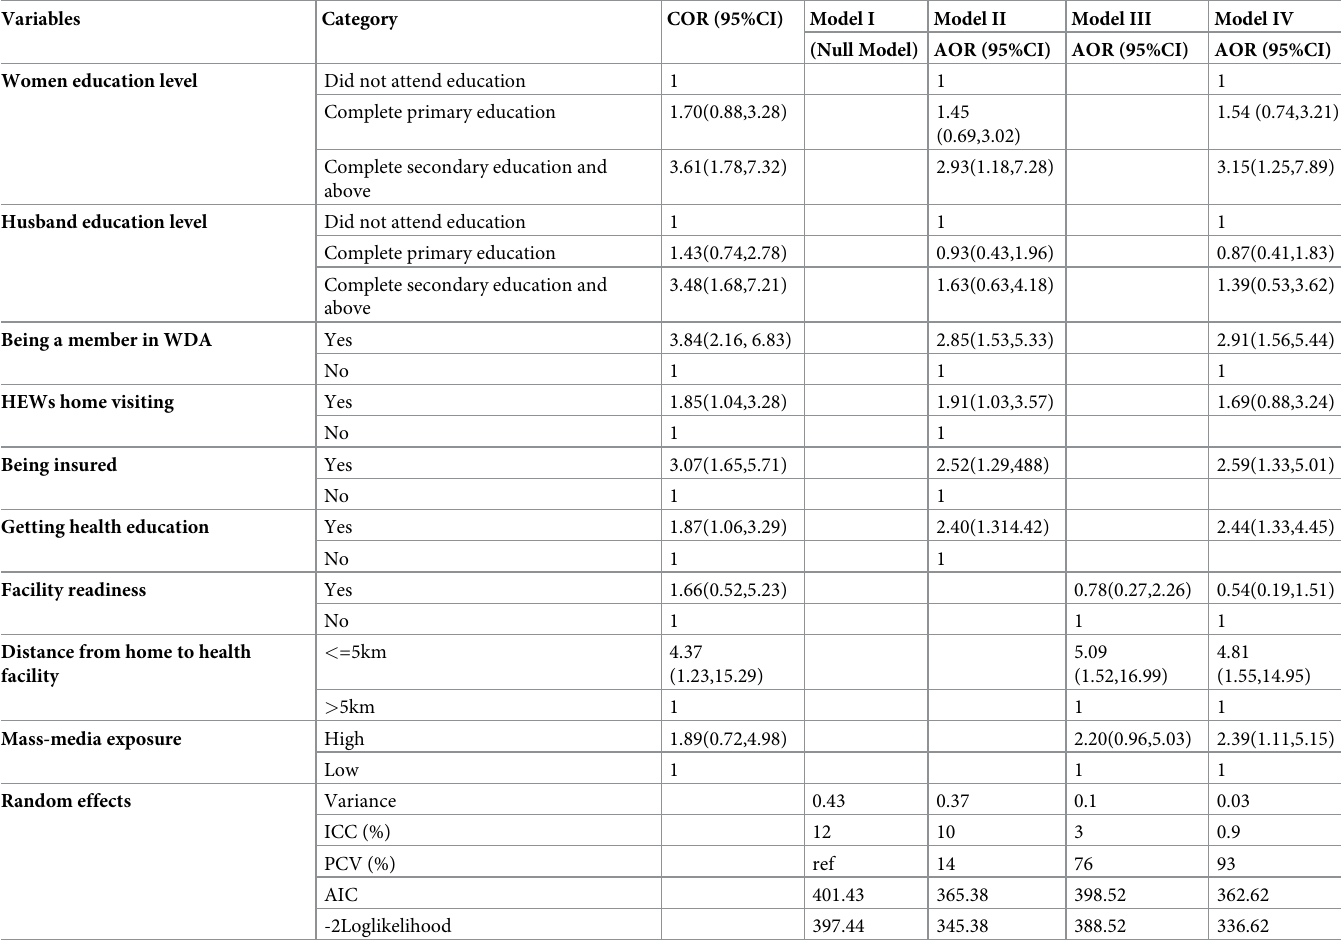
Table 3. Multivariable multilevel logistic regression analysis of predictors of women’s completion of maternal continuum of care in Northwest Ethiopia, 2020 (n =